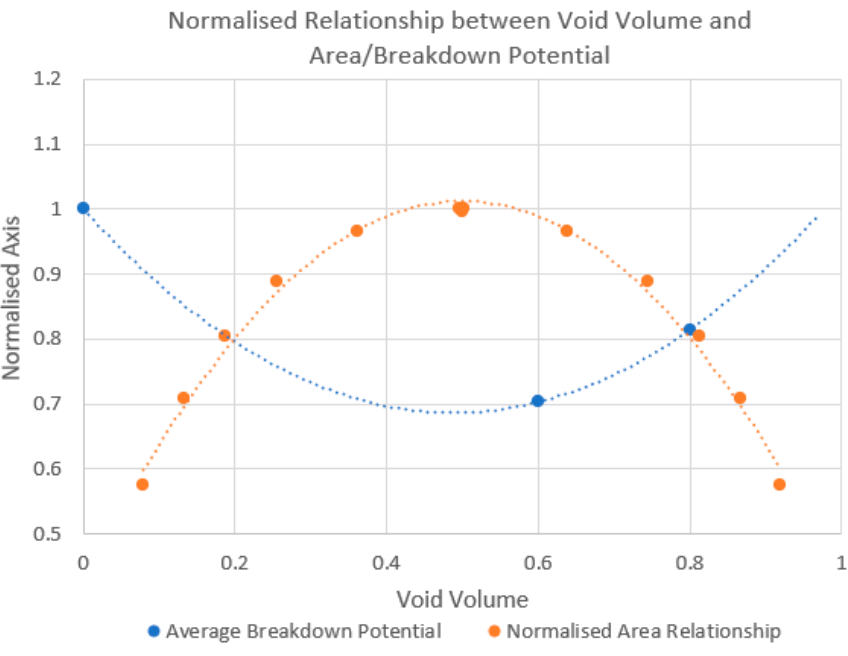
Figure 8. Generalized inverse parabolic relationship between breakdown potential and gyroid area to void volume ratio. Gyroid area curve adapted from Grobe-Braukman [49]. All values are normalised to a maximum value of one.